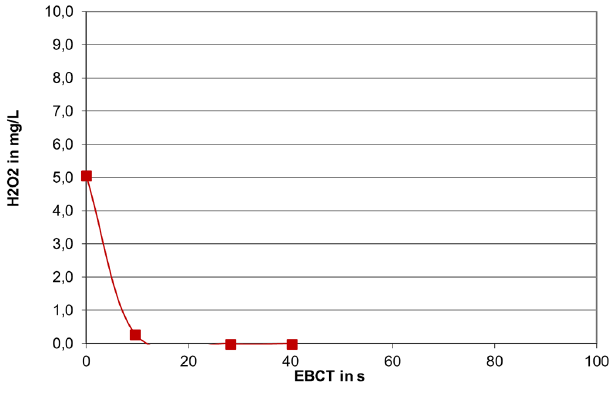
Figure 4. Decomposition over MC in R20 (bed height 0.36m, flow rate 40mh − 1 , water temperature 11.7 ◦ C).